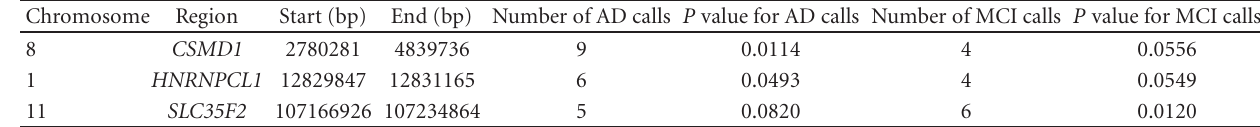
Table 5: Significant (uncorrected P < . 05, relative to healthy controls) genes present in either Alzheimer’s disease (AD) and/or mild cognitive impairment (MCI) participants, but not healthy controls using the whole genome